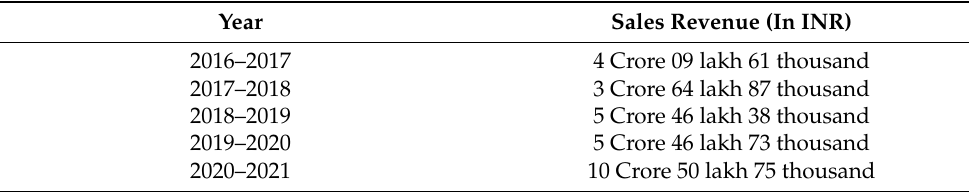
Table 4. Increase in sales revenue over the last five years (In Crores).